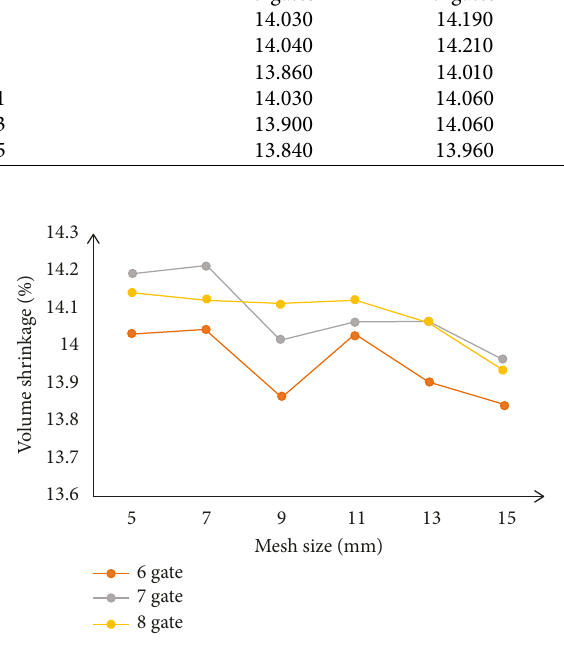
Figure 11: Diagram of mesh size and volume shrinkage. Figure 12: Diagram of mesh size and